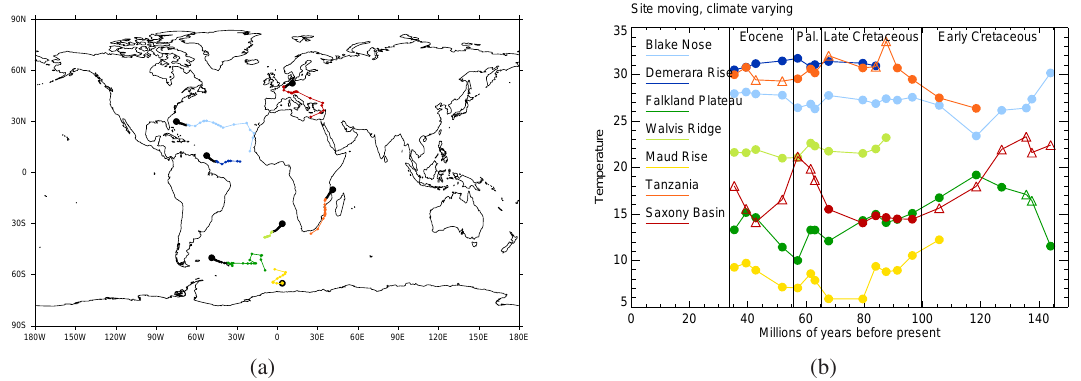
Figure 9. (a) The palaeolocation of seven key sites used for reconstructing climate of the CPE. Large black dots represent the modern location. Small black dots represent the location at each Stage post the CPE, and coloured dots represent the location at each Stage during the CPE, for those Stages that the modern ocean crust was present. (b) Climate evolution across the CPE, simulated by the model, as experienced at the same seven sites. Filled (open) symbols indicate that a particular site is marine (terrestrial) at a particular